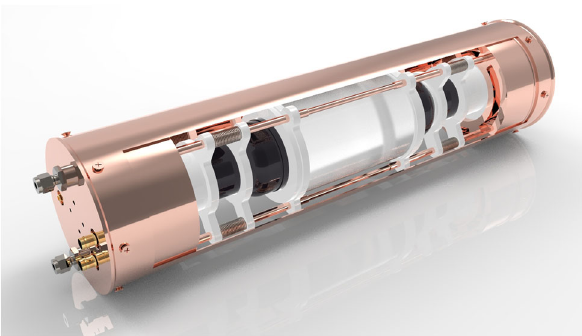
Fig. 1 Rendering of the detector module for the SABRE-PoP phase. The crystal is placed in a copper enclosure; the crystal wrapping is not shown. Two PMTs (black body) are coupled on each end of the crystal. PTFE holders (white) and copper rods keep the crystal and the PMTs in position